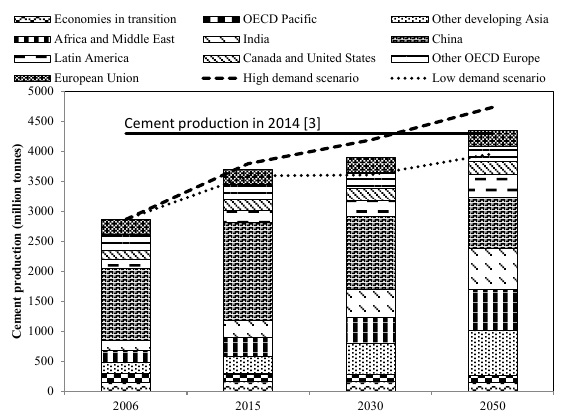
Figure 1. Average estimated cement production (data from